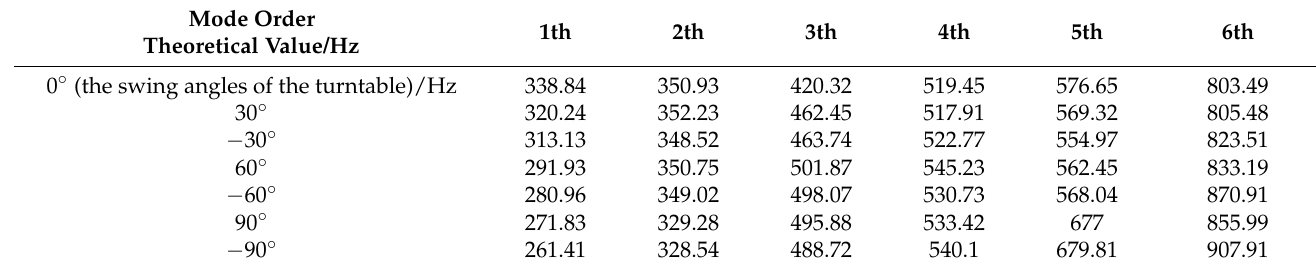
Table 4. First six-order natural frequencies of the turntable at different swing angles.